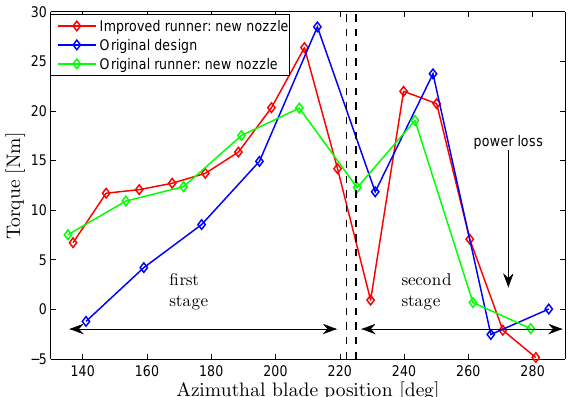
Figure 11. Comparison of torque production in the runner between the improved and the original runner with the new nozzle for the 7 kW turbine at η max . Note that the original runner has N b = 20 and β 1 b = 30 ◦ , whereas the new runner has N b = 35 and β 1 b = 39 ◦ . For the purpose of comparison, the data are computed at each blade position and normalized with the torque for 35 blades. The first stage contributions for the original nozzle, the new nozzle with the original runner, and the new nozzle with improved runner are respectively 62%, 69%, and 73%